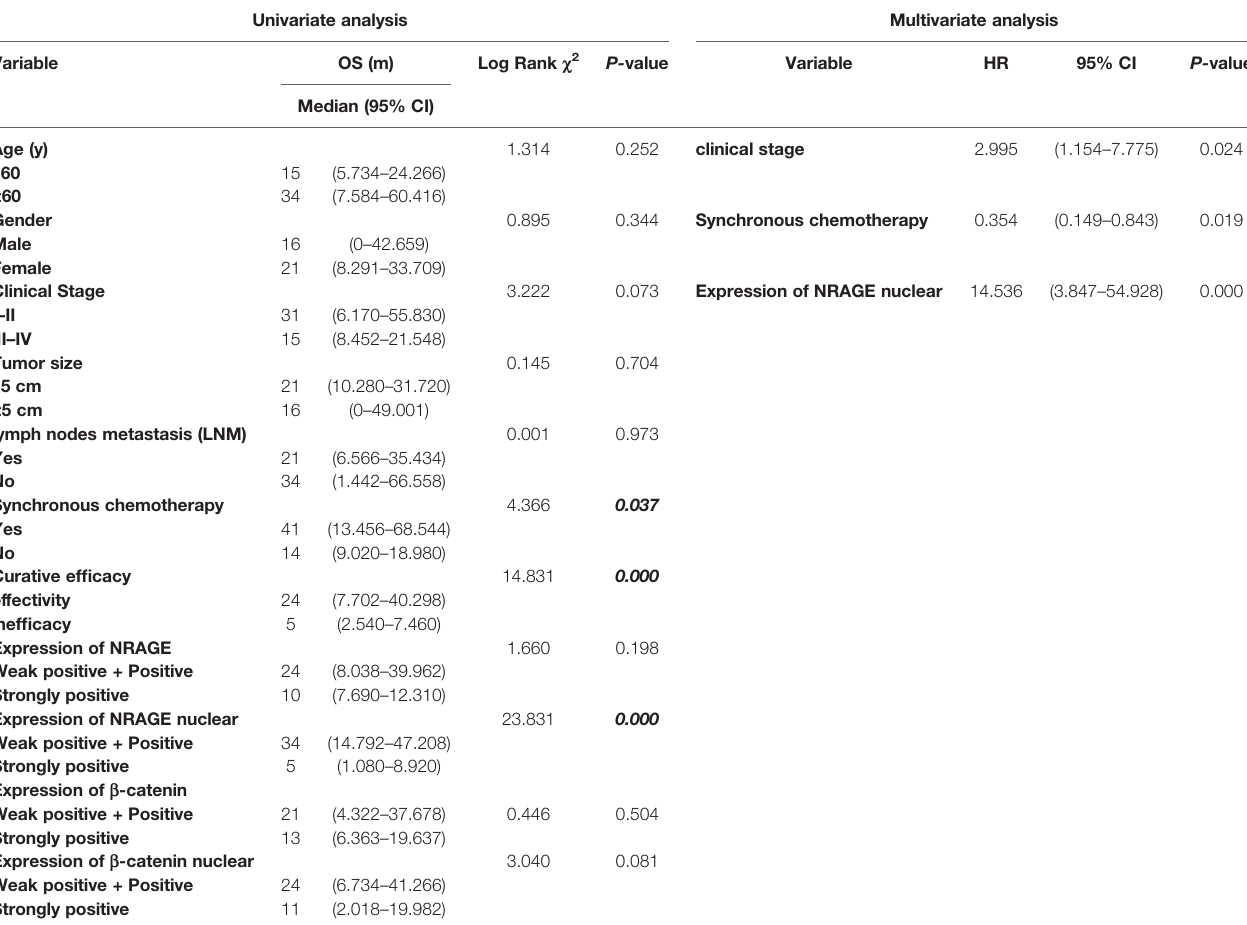
TABLE 2 | Univariate and Multivariate analysis of various prognostic parameters in patients with ESCC following Radical radiotherapy.